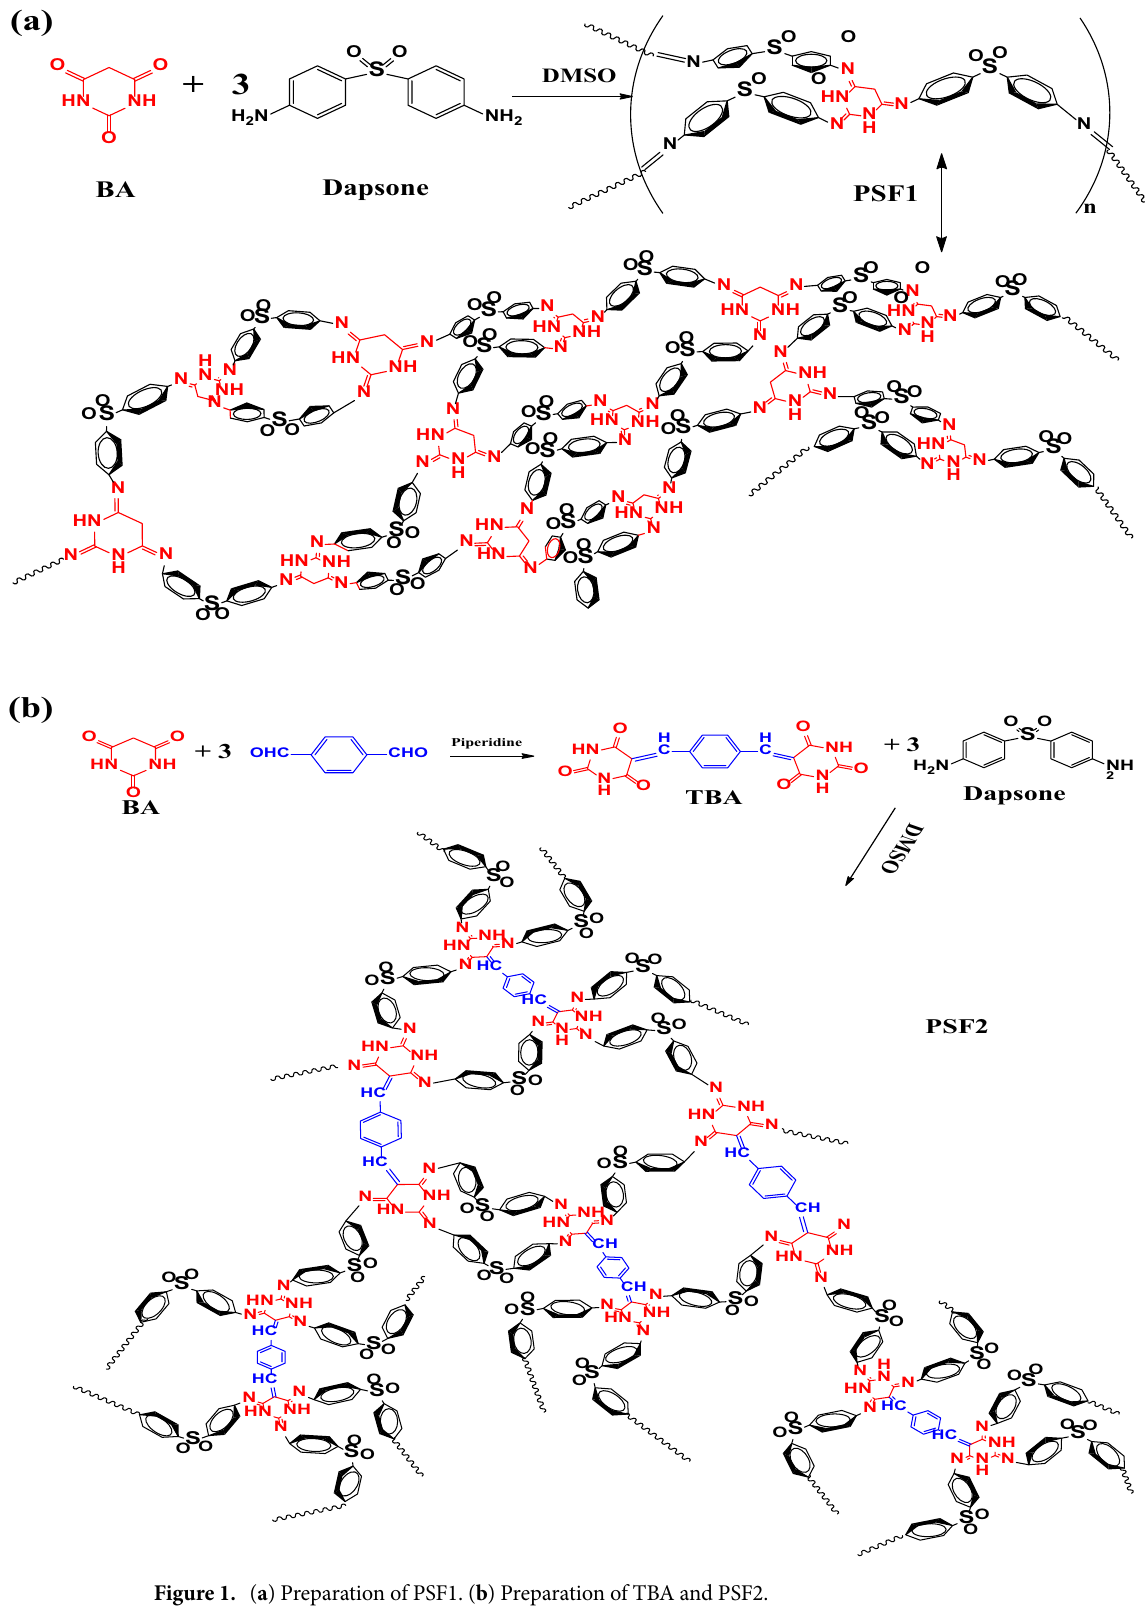
Figure 1. ( a ) Preparation of PSF1. ( b ) Preparation of TBA and